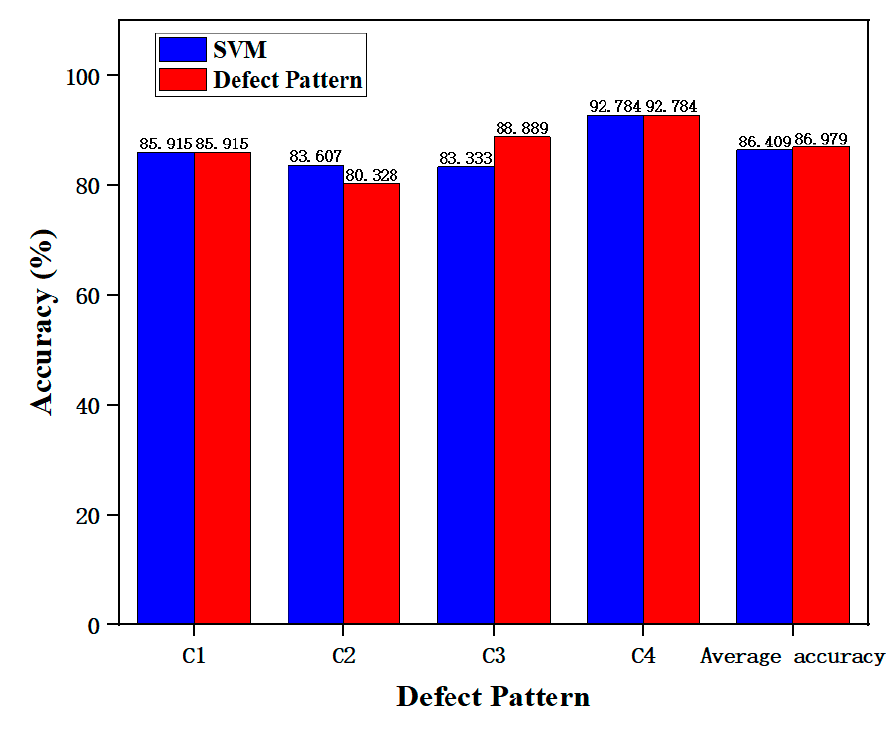
Figure 10. Accuracy comparison between SVM and BP neural network